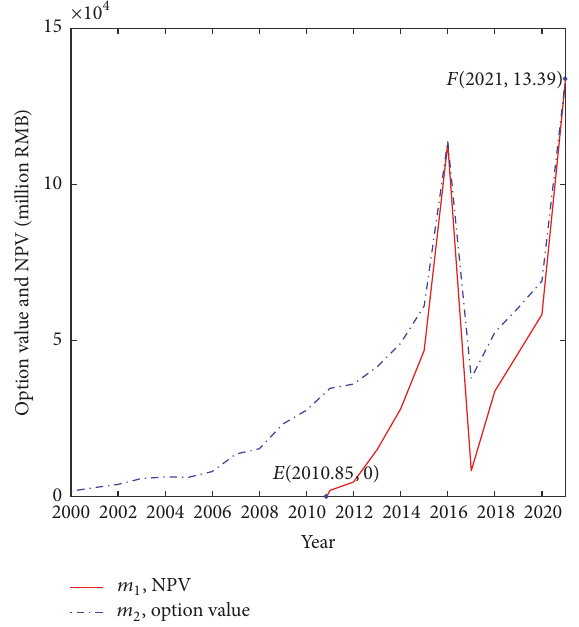
Figure 10: Option value and NPV of introducing different sizes of logistics parks without government